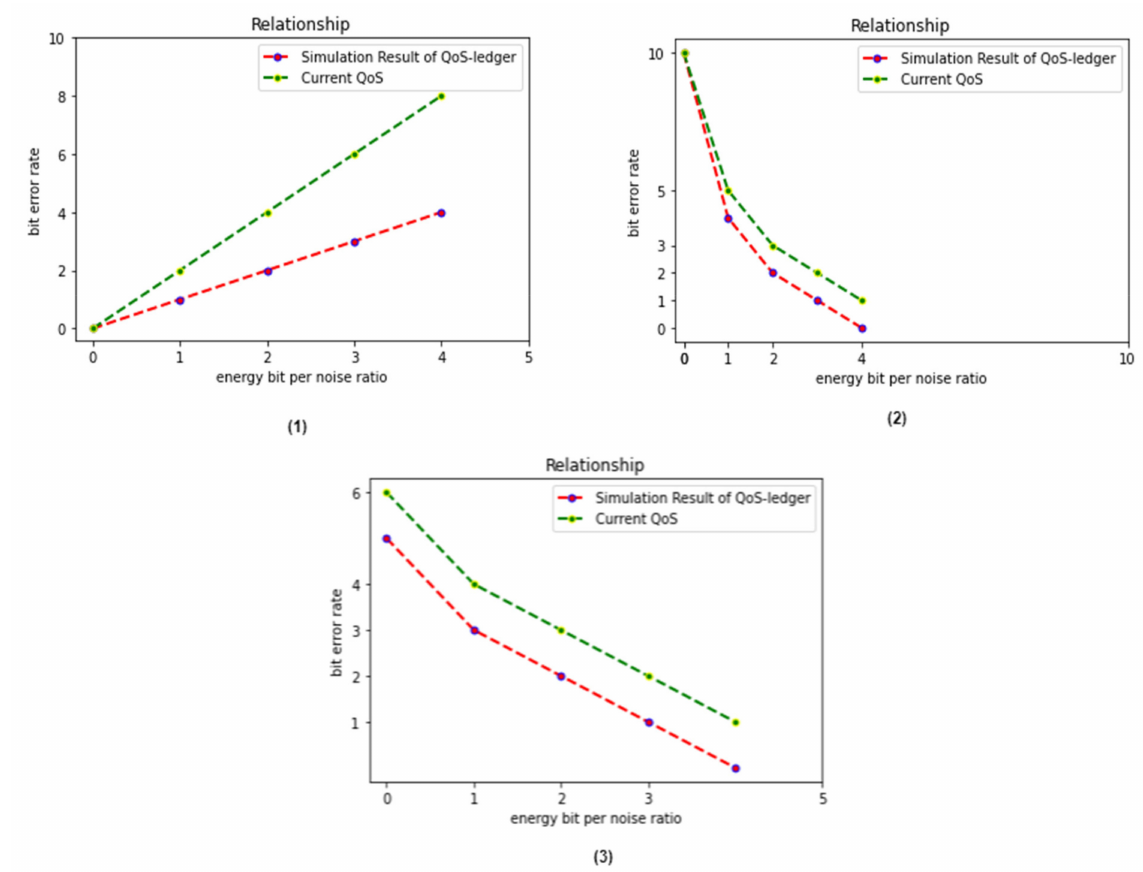
Figure 4. Relationship between the Energy Bit Per Noise Ratio and Bit Error Rate: ( 1 ) Shows the simulation result of QoS-ledger and existing QoS architecture, ( 2 ) Error Bit for other baselines, and ( 3 ) Error Bit for Current